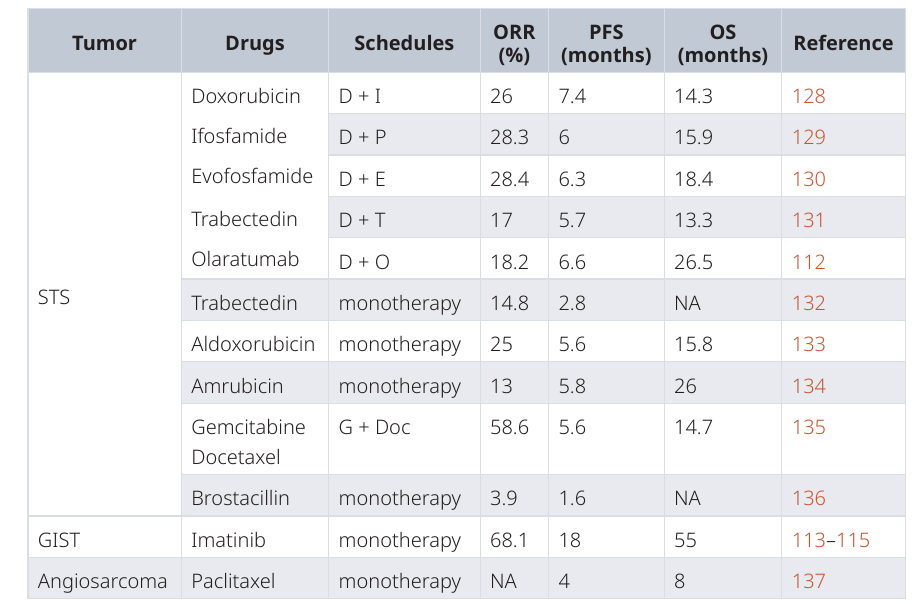
Table 4. Approved first-line treatments for sarcomas. ORR, overall response rate; PFS, progression free survival; OS, overall survival; STS, soft tissue sarcoma; GIST,